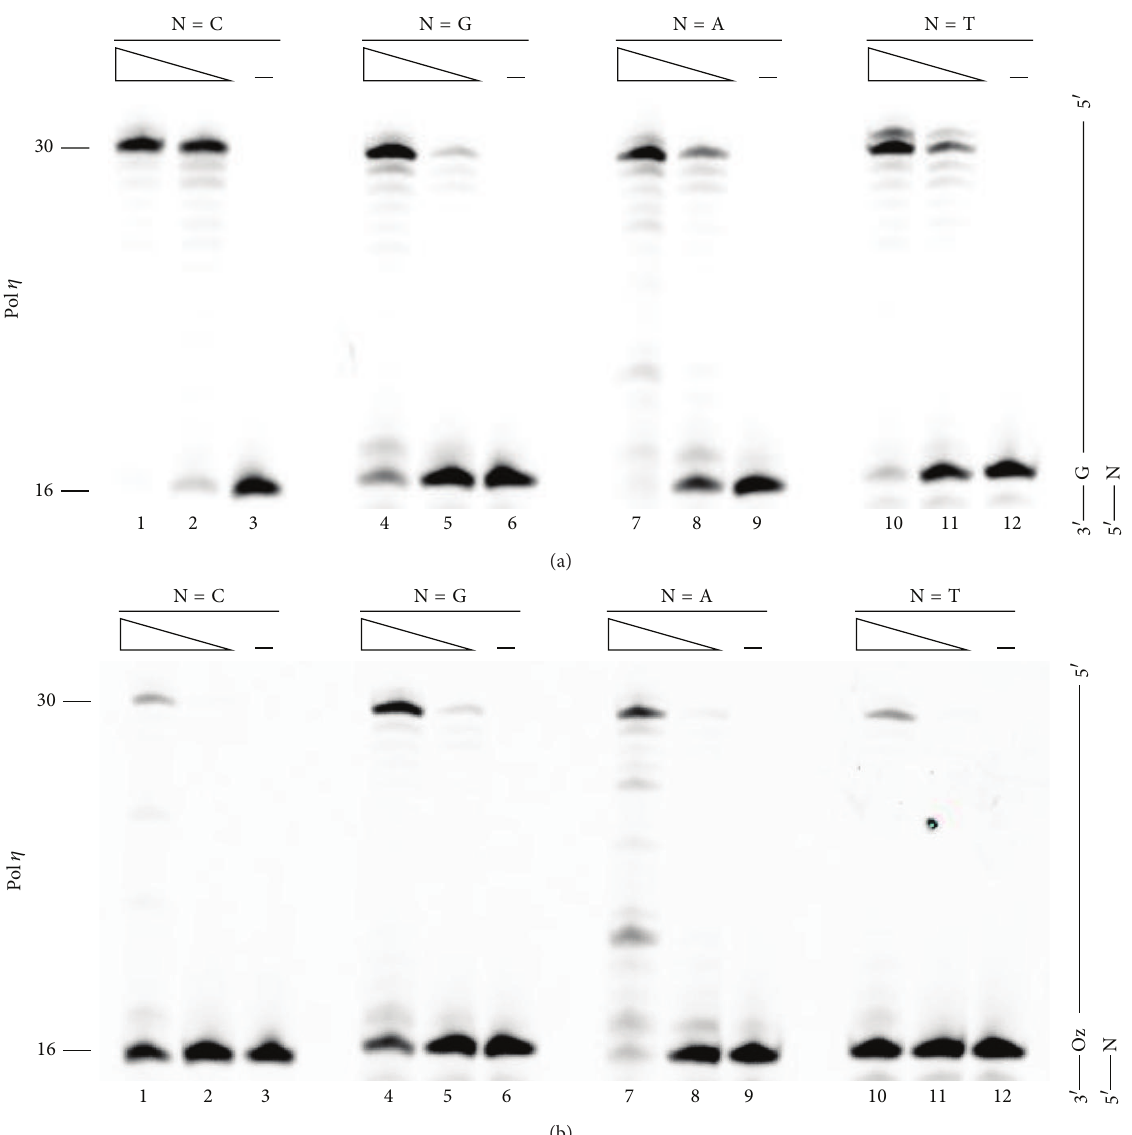
Figure 4: Extension from primer ends by Pol 𝜂 . Each primer contained a different nucleotide at the 3 󸀠 end (indicated by N, where N was C, G, A, or T in lanes 1–3, 4–6, 7–9, and 8–12, resp.) opposite G (a) or Oz (b). The amount of Pol 𝜂 was 11.5ng in lanes 1, 4, 7, and 10 or 1.15ng in lanes 2, 5, 8, and